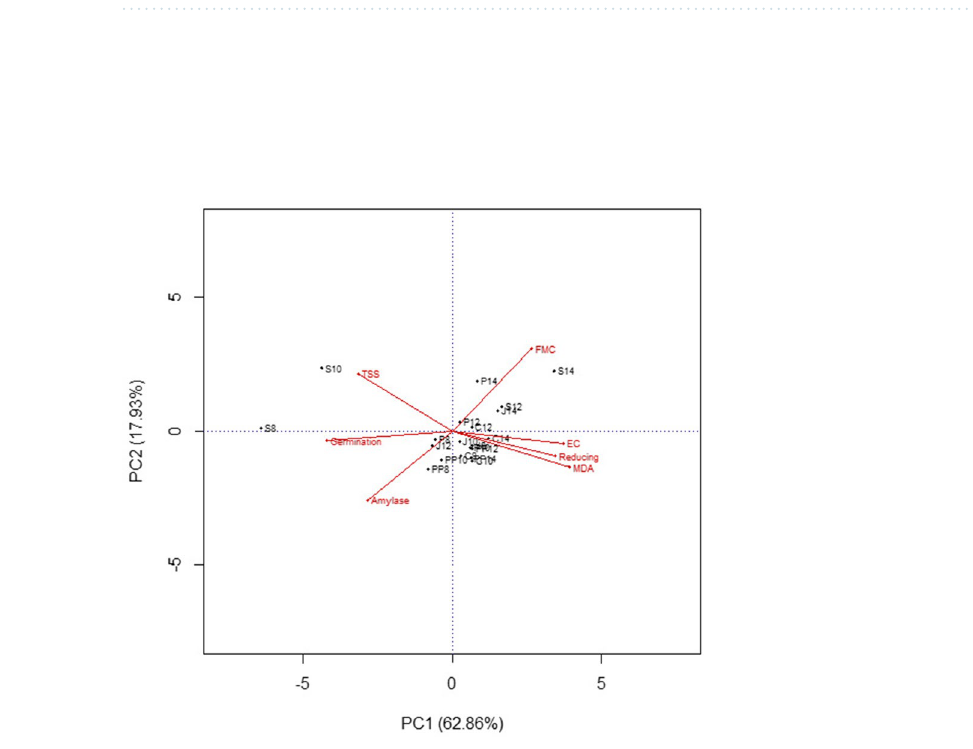
Figure 6. Total soluble sugars ( a ) and reducing sugars ( b ) of quinoa seed stored at various seed moisture levels in different packaging materials.